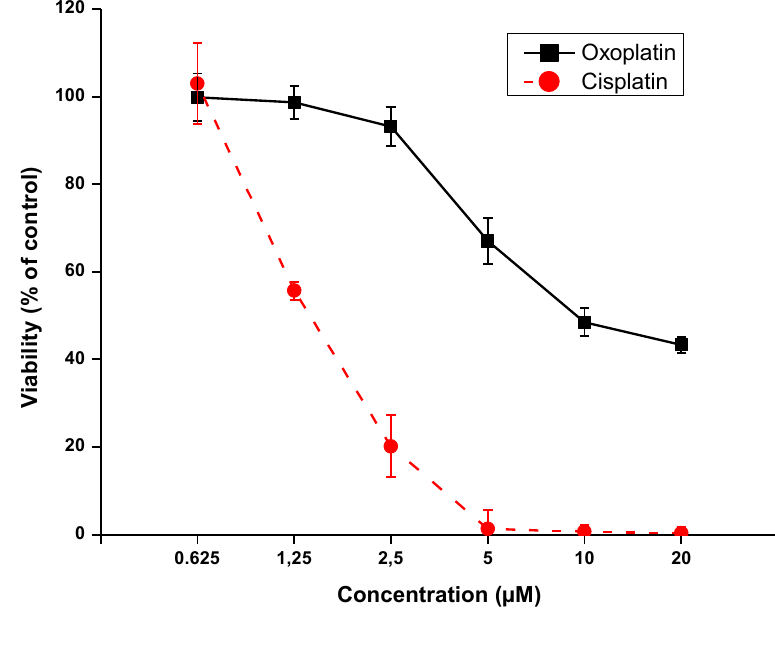
Figure 4. Viability of NCI-H526 cells exposed to either oxoplatin or cisplatin at six different drug concentrations for four hours and subsequently kept for four days in tissue culture prior to the MTT assay (all values significantly different with p < 0.001, except for the non-significant difference at the lowest drug concentrations